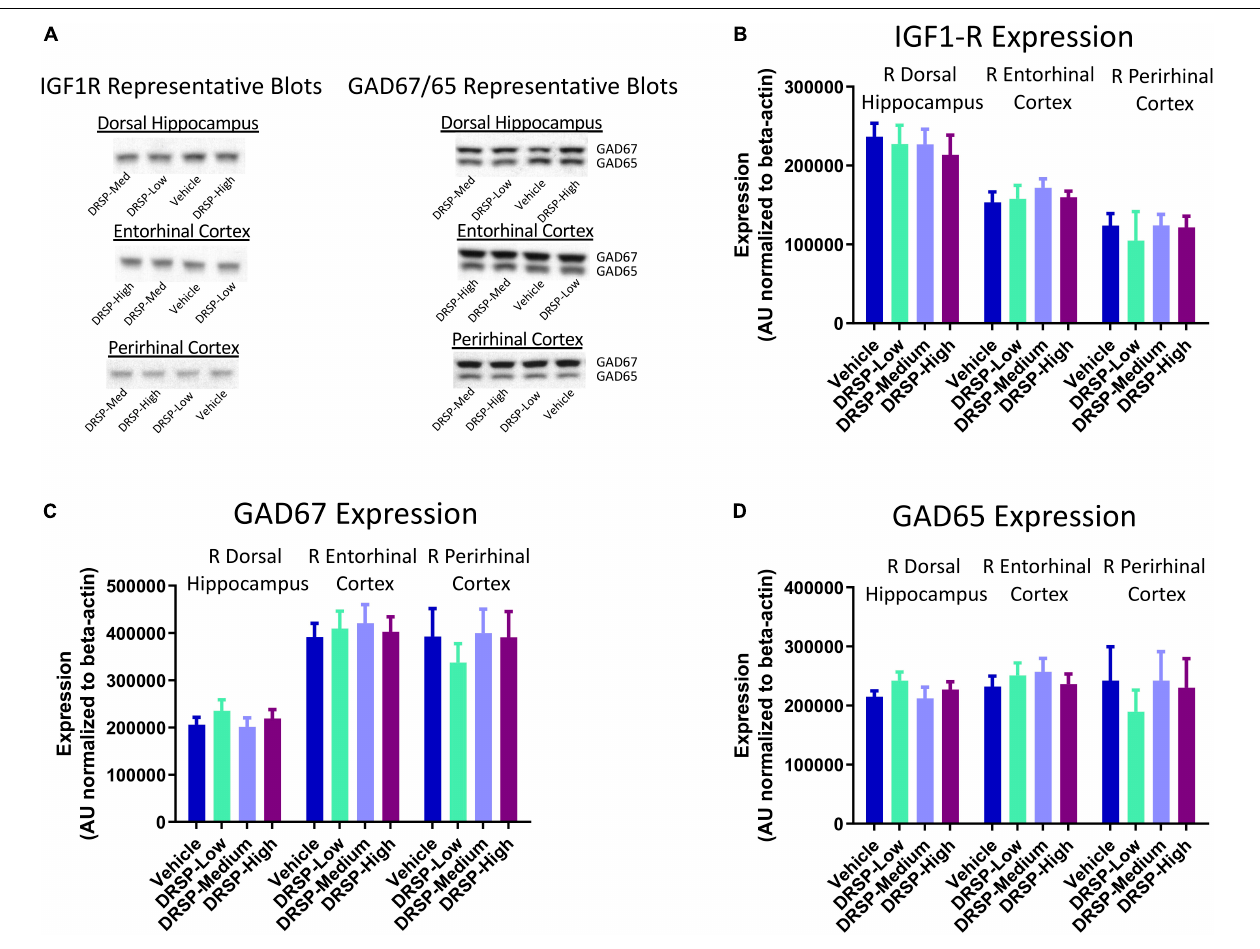
FIGURE 3 | Experiment 1 Western blot protein analysis. (A) Representative images of IGF1-R, GAD65, and GAD67 western blot analysis within the dorsal hippocampus, entorhinal cortex, and perirhinal cortex. There were no Treatment differences in IGF1-R expression (B) , GAD67 expression (C) , or GAD65 expression (D) for any brain region evaluated. Vehicle n = 10, DRSP-Low n = 10, DRSP-Medium n = 10, and DRSP-High n = 10.